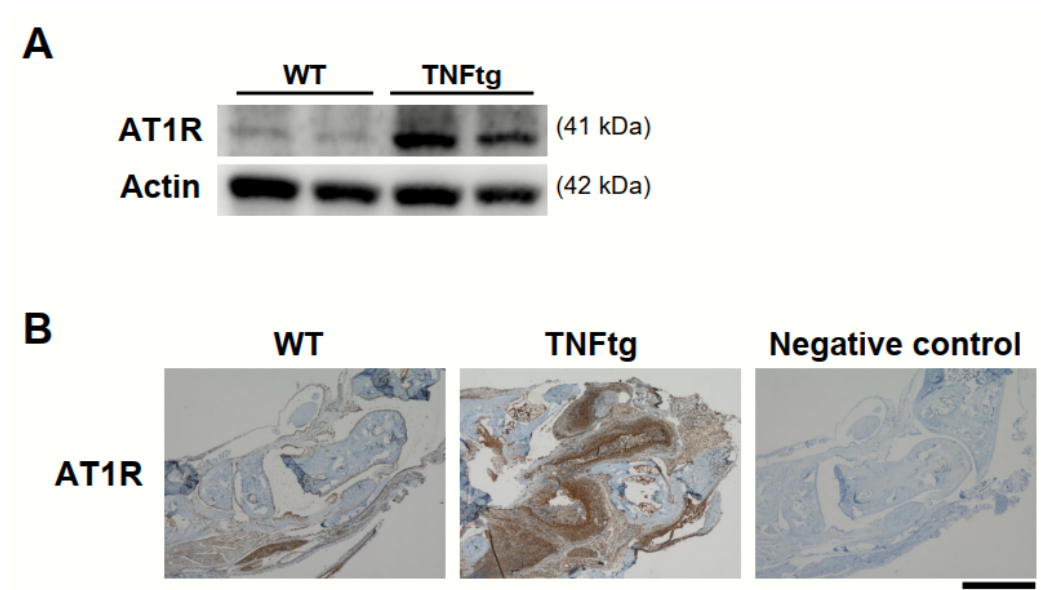
Figure A1. The protein expression of angiotensin II type 1 receptor (AT1R) in the joint tissues was increased in tumor necrosis factor-transgenic (TNFtg) mice. ( A ) Western blot analysis of AT1R expression in the fore paw tissues. The fore paw samples were obtained from 16-week-old wild-type (WT) and TNFtg mice. ( B ) Immunohistochemistry staining images of AT1R. The expression of AT1R in the left ankle joint specimens was determined. Original magnification ×40. A tissue specimen processed without the primary antibody is presented as a negative control. Detailed methods are described in the Supporting Information.